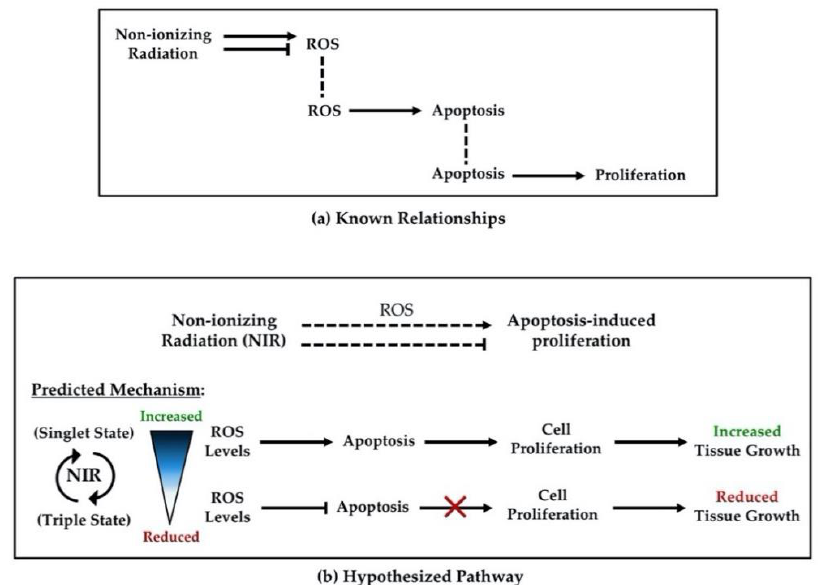
Figure 3. Diagram of known and proposed interactions. (a ) Known relationships from the literature between non-ionizing radiation (NIR) and reactive oxygen species (ROS); ROS and apoptosis; apoptosis and cell proliferation. ( b ) Hypothesized pathway by which non-ionizing radiation could modulate apoptosis-induced proliferation via changes in ROS levels. Barred lines: inhibition. Arrows: activation. Dotted lines: predicted interactions.